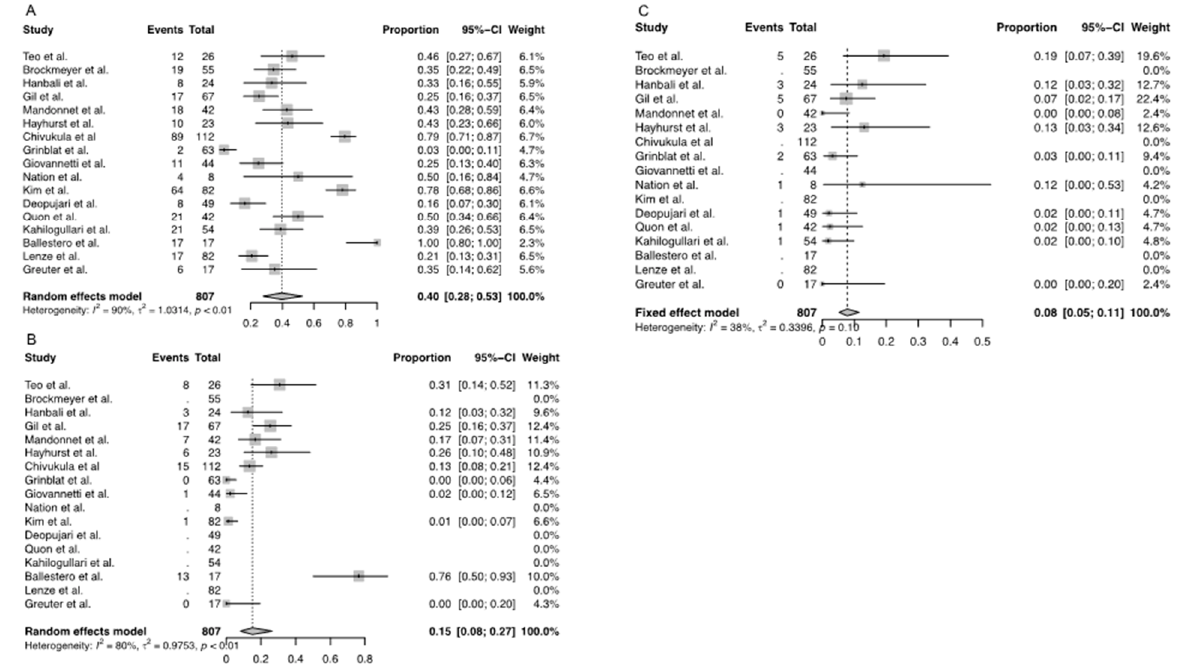
Figure 3. Weighted incidence rate of ( A ) transient complications, ( B ) permanent complications, and ( C ) mortality among all included studies for the review. [2–5,7,8,13–23].